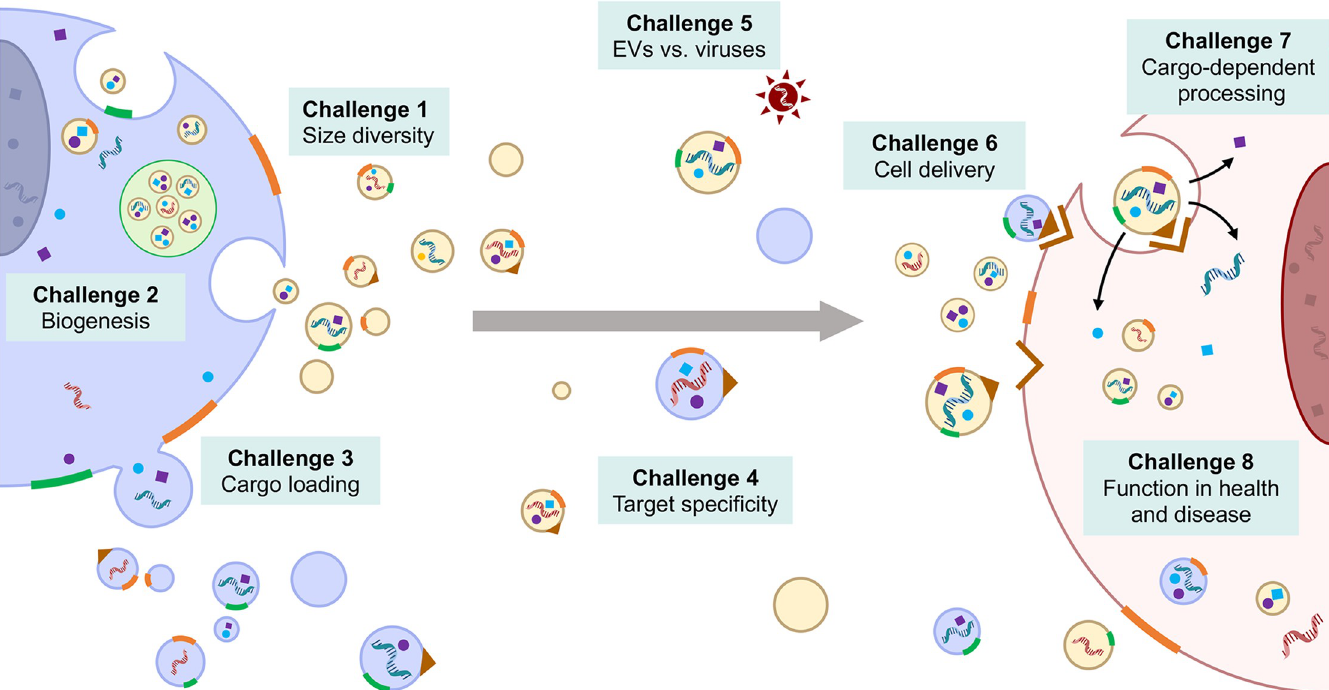
Fig 1. Progress in the field of EV biology depends on solving at least eight challenging problems, which refer to the “unsolved mysteries” described in the corresponding text sections. EV, extracellular vesicle.